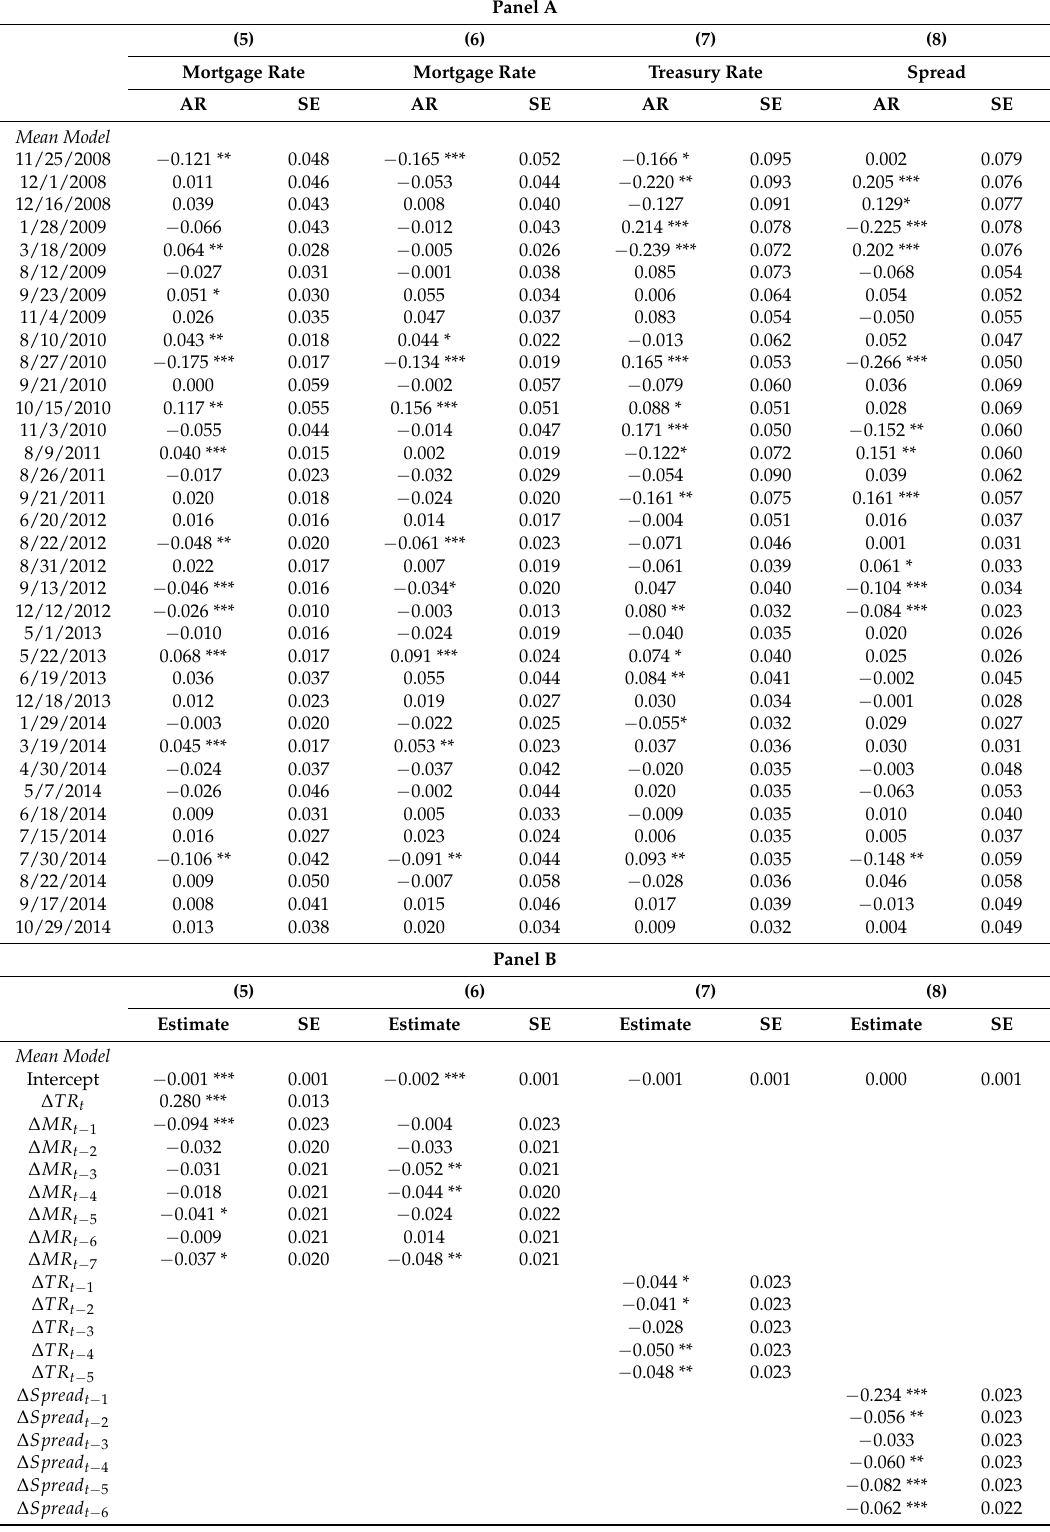
Table 1. Abnormal returns (ARs) in 1-day windows. We run four regressions (Equations (5) to (8)) with 1-day event window. For each regression, the ARs and standard errors (SEs) on QE event days are reported in Panel A. Coefficient estimates and SEs of control variables and GARCH components are reported in Panel